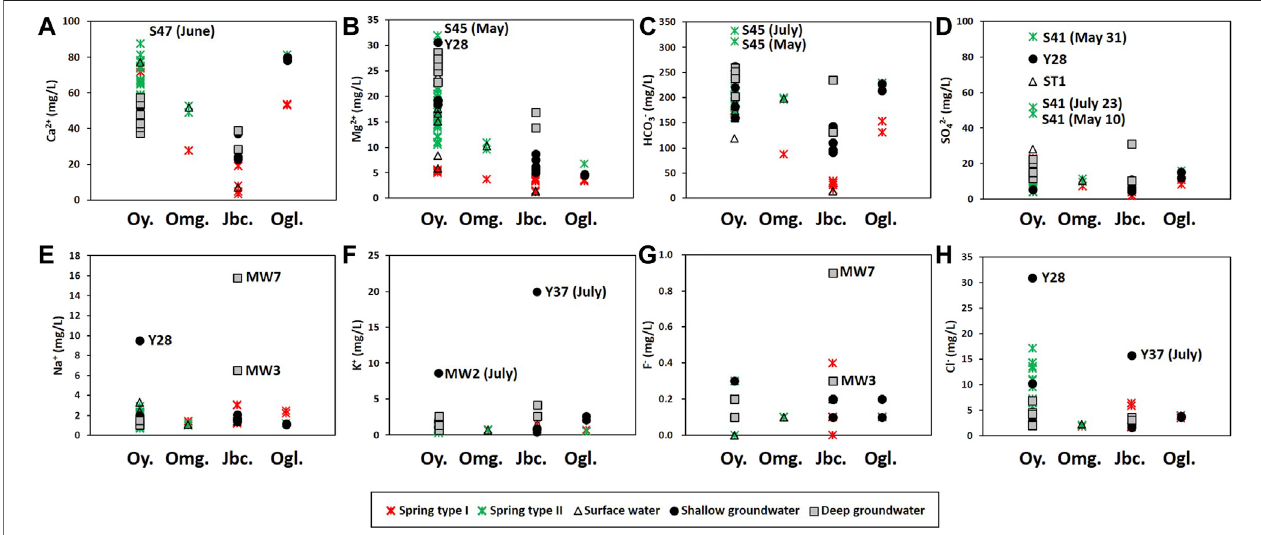
FIGURE 7 | Major elements by lithology: Oy. (cid:1) Yeongheung Formation (limestone and dolomitic limestone), Omg (cid:1) Maggol limestone, Jbc (cid:1) Bansong Formation (mainly, metamorphosed shale and sandstone) including Jbs in Figure 1A , Ogl (cid:1) Kosong limestone (the white area at the east in Figure 1A ). The letters on the diagram indicate the names of distinct samples.